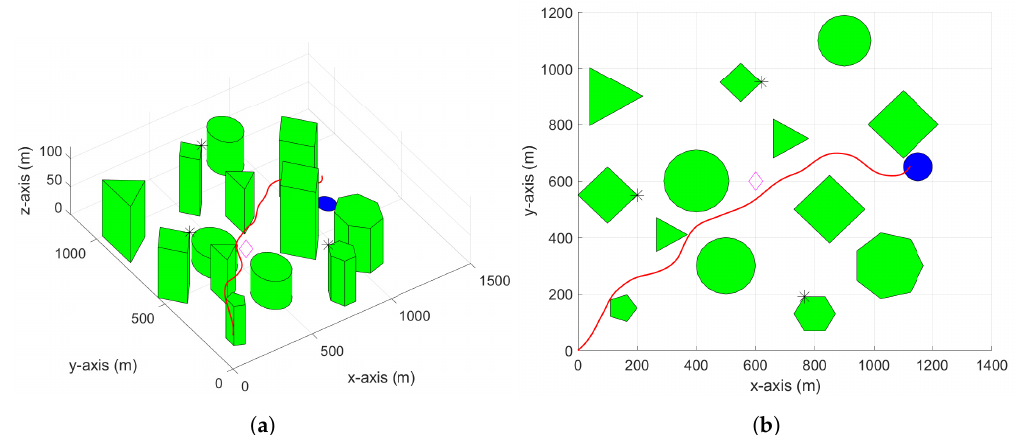
Figure 5. 3D ( a ) and 2D ( b ) views of the UAV trajectory by the proposed